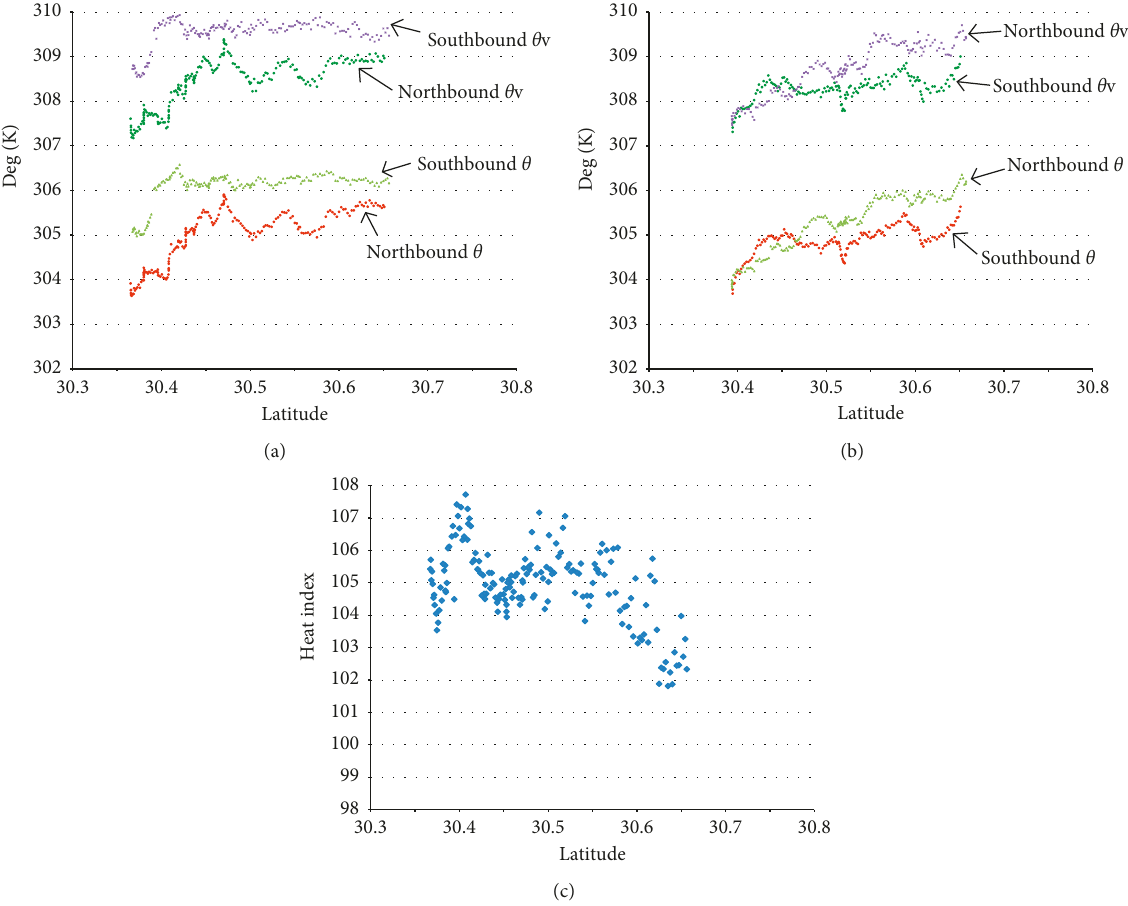
Figure 13: Space series of potential temperature and virtual potential temperature (K) from 10 August 2015. (a) Northbound Gulfport- Saucier from 1617 to 1651 UTC (1117–1151 CDT); southbound Saucier-Gulfport from 1833 to 1908 UTC (1333–1408 CDT). (b) Southbound Saucier-Biloxi from 1651 to 1717 UTC (1151–1217 CDT); northbound Biloxi-Saucier from 1805 to 1833 UTC (1305–1333 CDT). (c) NWS heat index from southbound Saucier-Gulfport 1833–1908 UTC (1333–1408